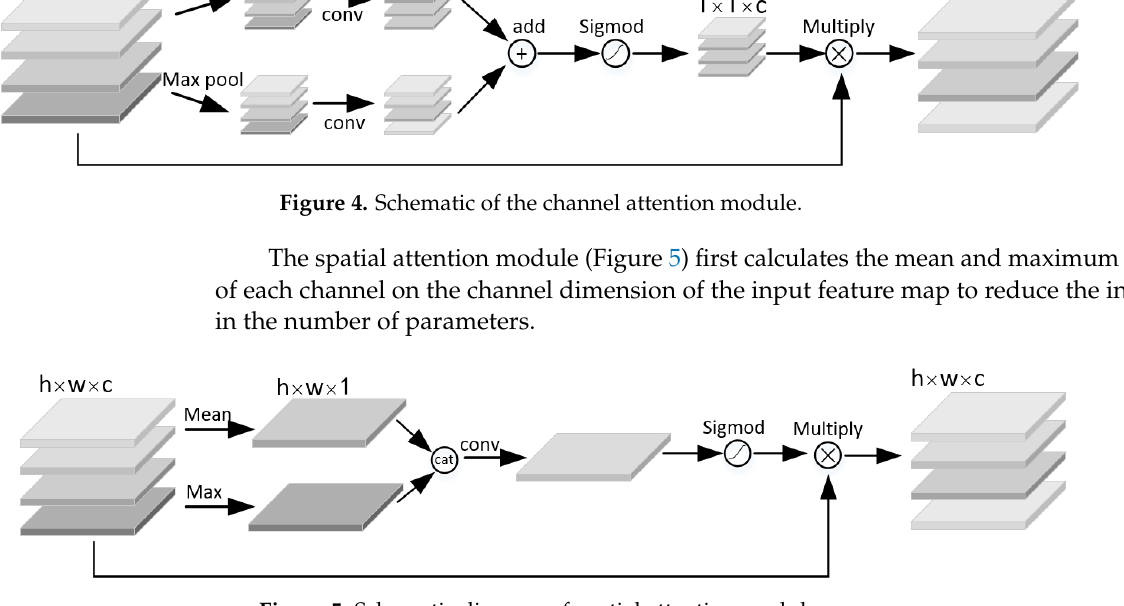
Figure 5. Schematic diagram of spatial attention module.